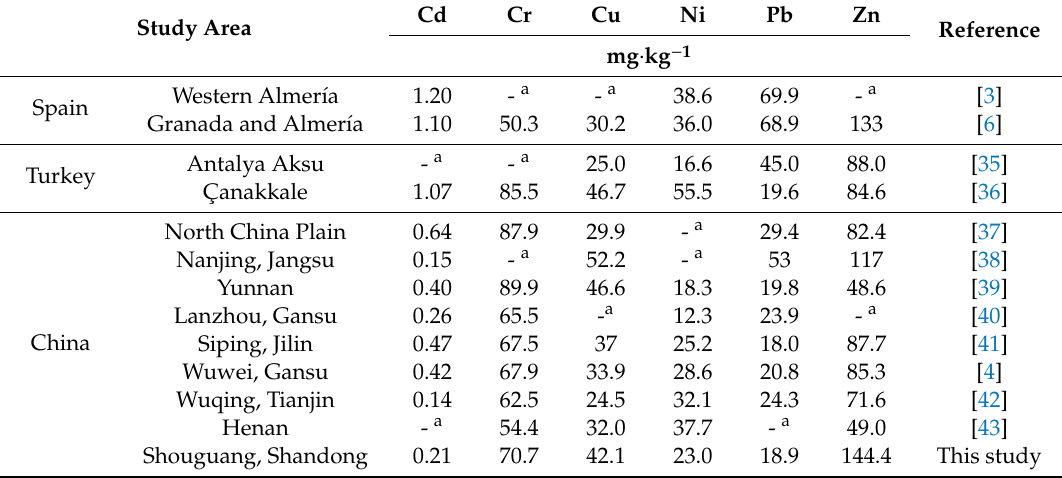
a Not available.